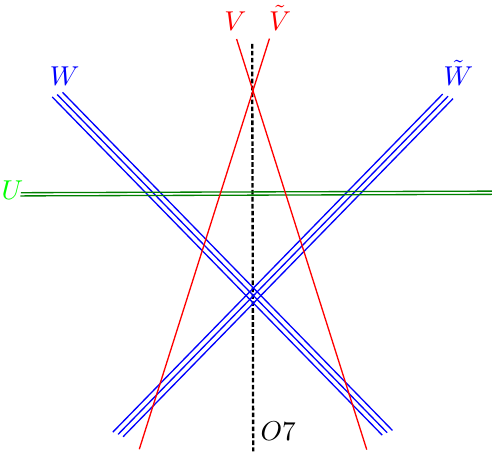
Figure 2 . Schematics of the brane stacks in the weakly coupled type IIB